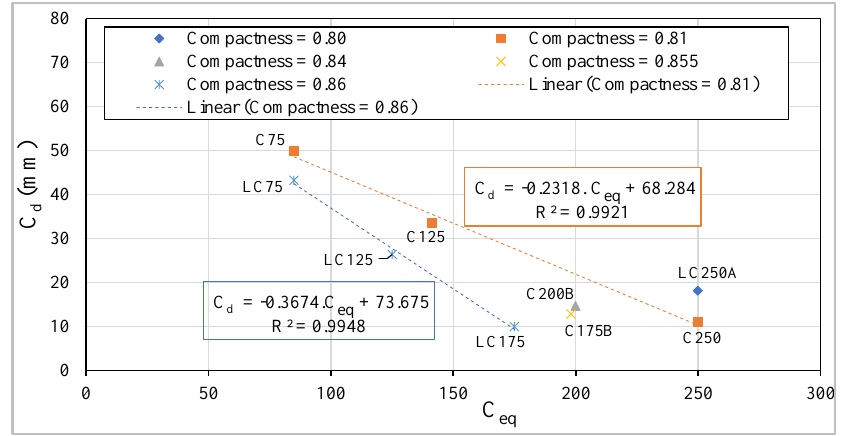
Figure 20. Relationship between C d vs. C eq.